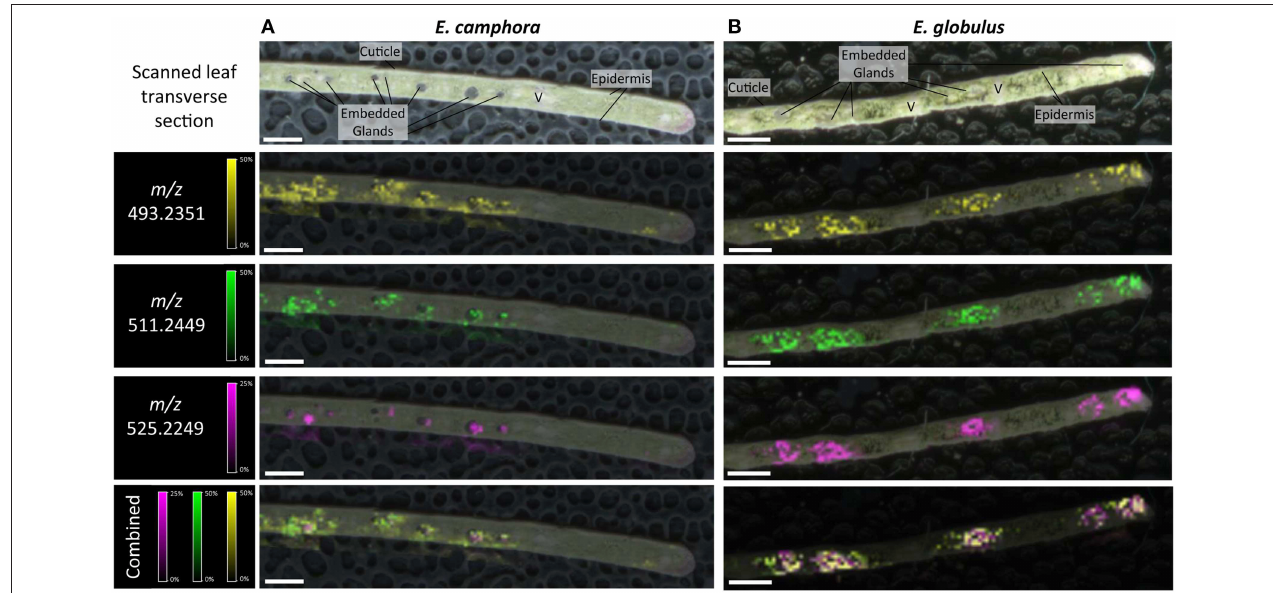
FIGURE 5 | Localization of FPCs in Eucalyptus camphora (A) and E. globulus leaves (B) . Leaf transverse sections were prepared for matrix-assisted laser desorption ionization-mass spectrometry imaging (MALDI-MSI). Corresponding ion maps of different FPCs are shown: yellow; m/z 493.2351; [M + K] + , green m/z 511.2449; [M + K] + , pink m/z 525.2249; [M + K] + , and a combination of all selected ions overlaid. FPCs are associated to the embedded glands in both species. Some FPC ions also localize to the epidermis. All images are root mean square (RMS) normalized, with internal scaling of 50% for the ions m/z 493.2351 and 511.2449, and 25% for m/z 525.2249. Scale bar = 500 µ M. V, vascular tissue.